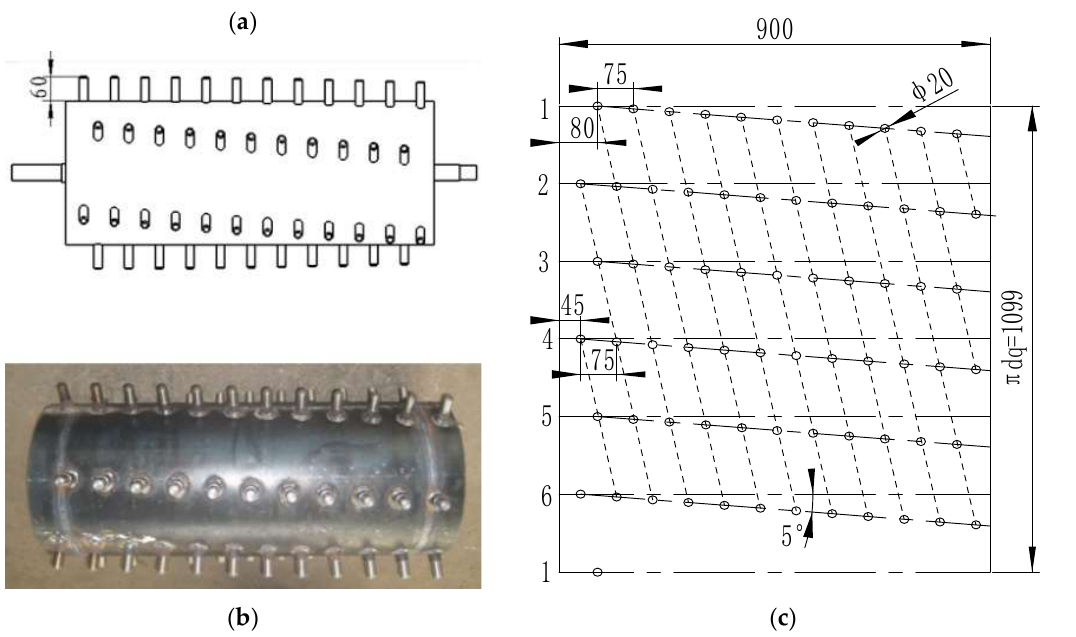
Figure 2. Tangential flow drum structure and column tooth arranged expanded view (magnified view). ( a ) The 3D model, ( b ) physical picture, ( c ) column teeth arranged expanded view.